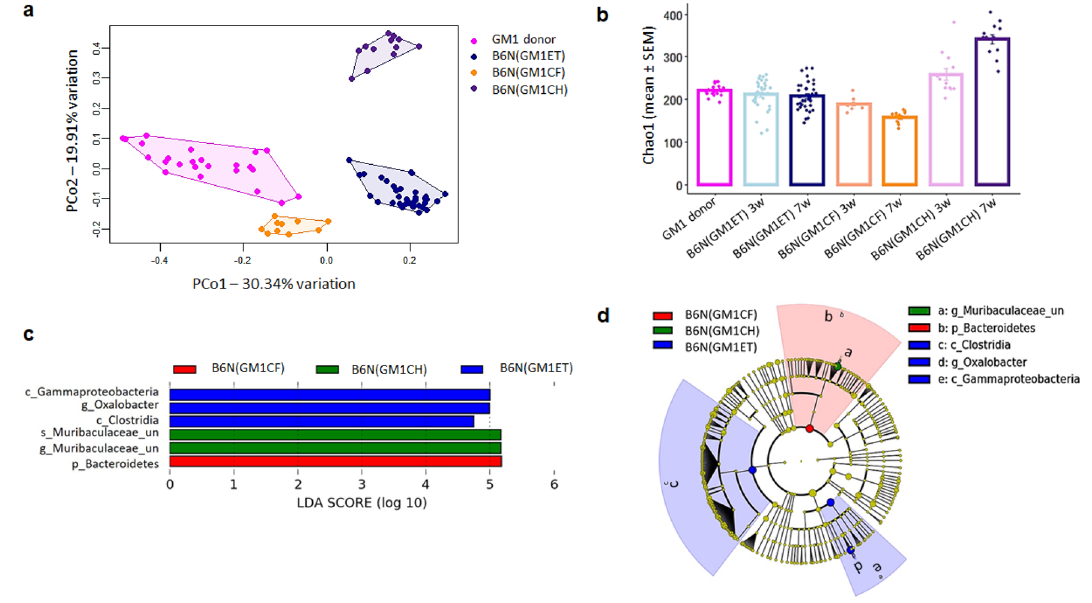
Figure 6. Influence of different transfer methods on transfer efficiency when transferring low richness GM1 to B6N mice . (a) Principal Coordinate Analysis plot of OTUs from feces of 7-week-old B6N mice receiving GM1 via embryo transfer (ET), cross fostering (CF), and co-housing (CH) as compared to their CD-1(GM1) donors showed a main effect of transfer method ( p = 0.001; F = 44.54, Bray–Curtis). ( b ) Statistical analysis (ANOVA) of the Chao-1 index of data from the same B6N mice also showed a main effect of transfer method at both 3 weeks ( p = 3.77e-6; F = 11.11) and 7 weeks ( p = 2.2e-16; F = 96.85). ( c ) Linear discriminant analysis (LDA) effect size (LEfSe) analysis and ( d) Cladogram showed compositional difference and taxa that were significantly overrepresented in each group when performing the comparison between mice groups that generated using ET, CF and CH method, B6N (GM1ET), B6N (GM1CF) and B6N (GM1CH) at 7 weeks of age. Cladogram annotation: p_ phylum, c_ class, o_ order, f_ family, g_ genus, or s_ species from inside to outside. Red, green and blue color-coded nodes stand for the species that are overrepresented in each